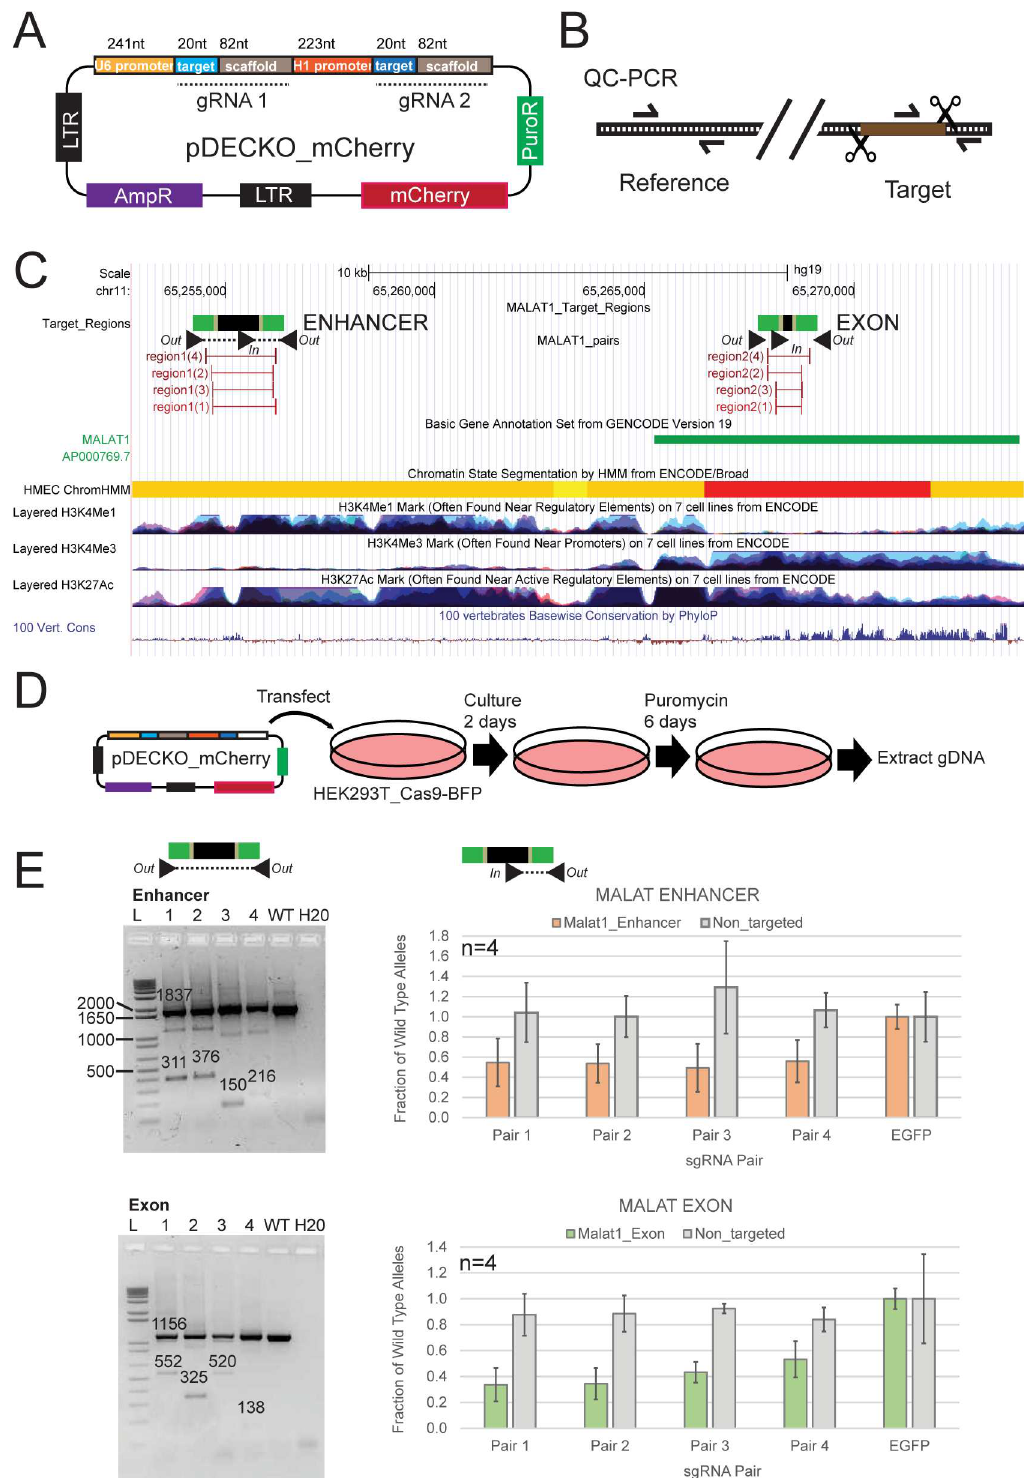
Fig 4. Measuring the deletion efficiency of paired sgRNA designs. (A) Structure of the pDECKO_mCherry vector. Note that the blue “target” regions contain protospacer sequences, andmust be clonedas appropriate for eachtarget region,whilethe grey “scaffold” regionsare constantfor all experiments. Note the presenceof mCherryandpuromycin selection markers. pDECKO_mCherryis compatible withlentivirusproduction or transfection. (B) Outlineof the